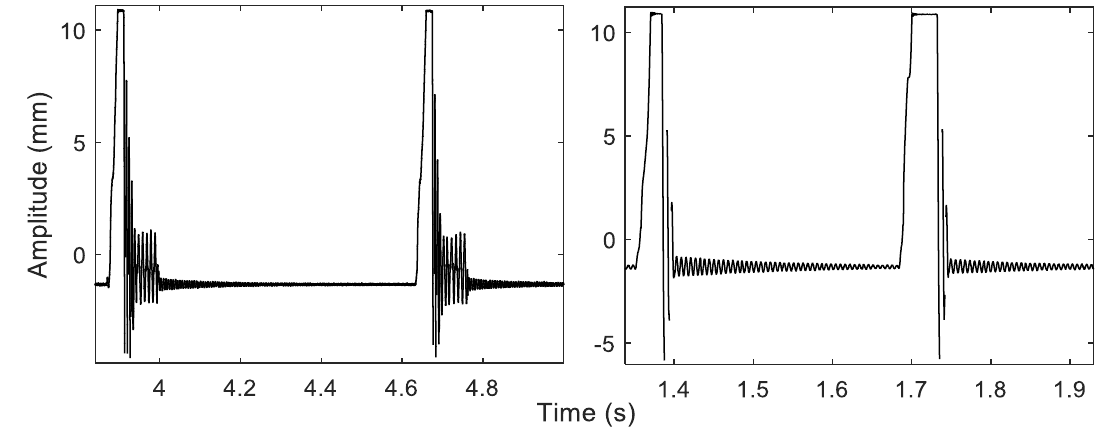
Fig. 8 Robustness tests performed on the closed loop system with integer (left) and fractional (right)